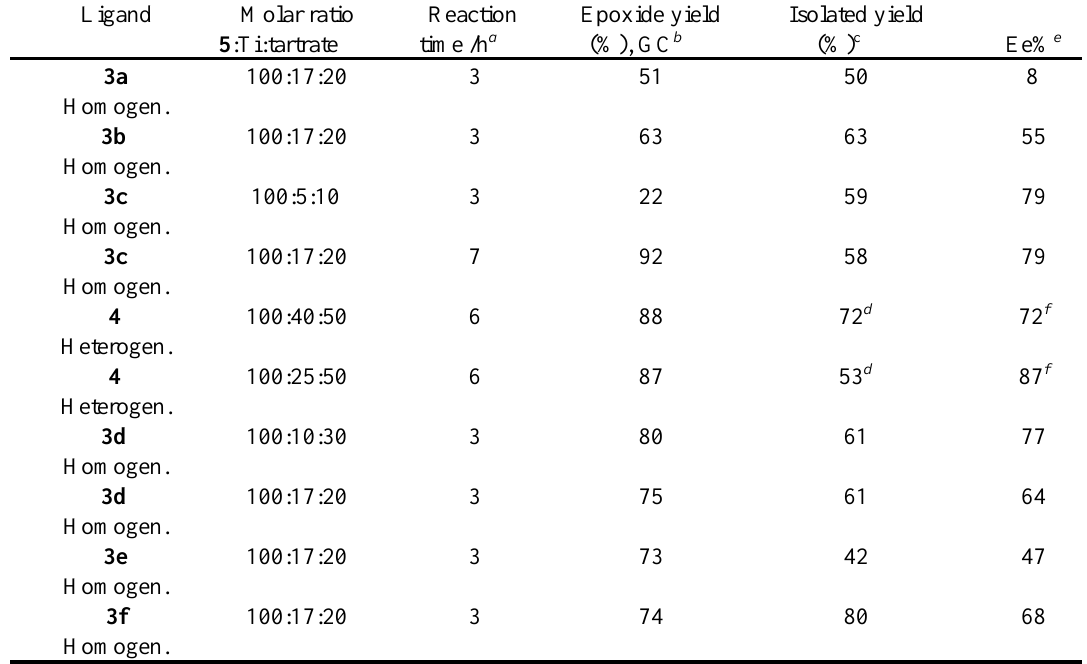
at - 20 (cid:176) C (Scheme 4